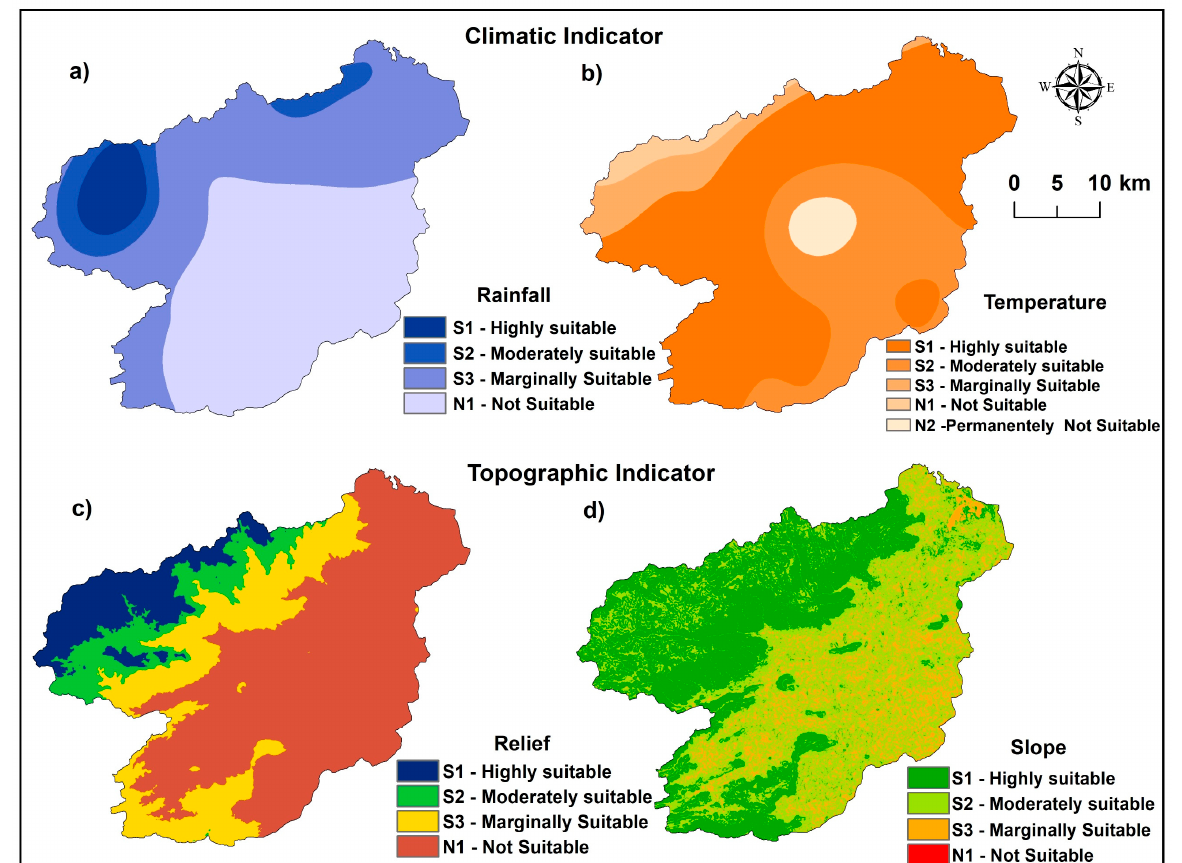
Figure 3. Suitability classes of the climatic indicators ( a ) rainfall and ( b ) temperature, and topographic indicators ( c ) relief and ( d ) slope.